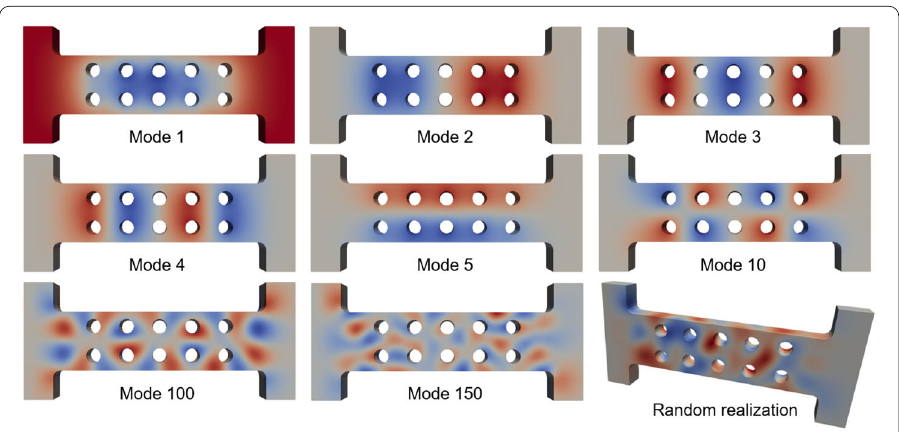
Fig. 5 Construction of random temperature fields. 150 zero-mean temperature fluctuation modes are generated, randomly combined and then superposed to a reference temperature field to get random temperature